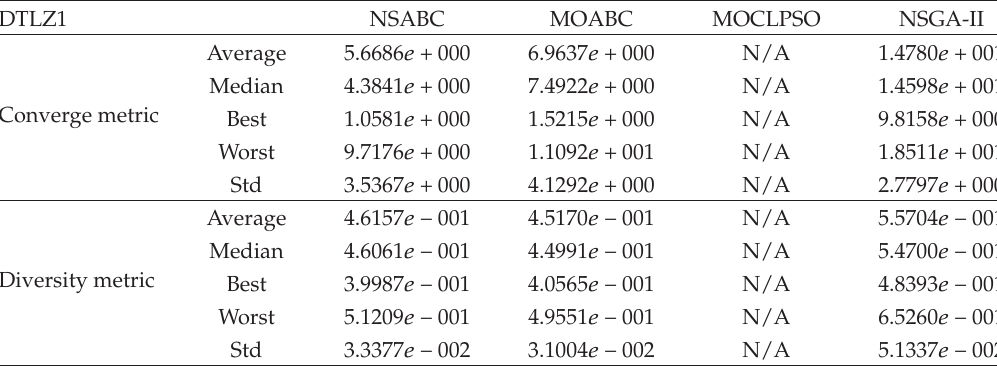
Table 15: Comparison of performance on DTLZ1 after 10000